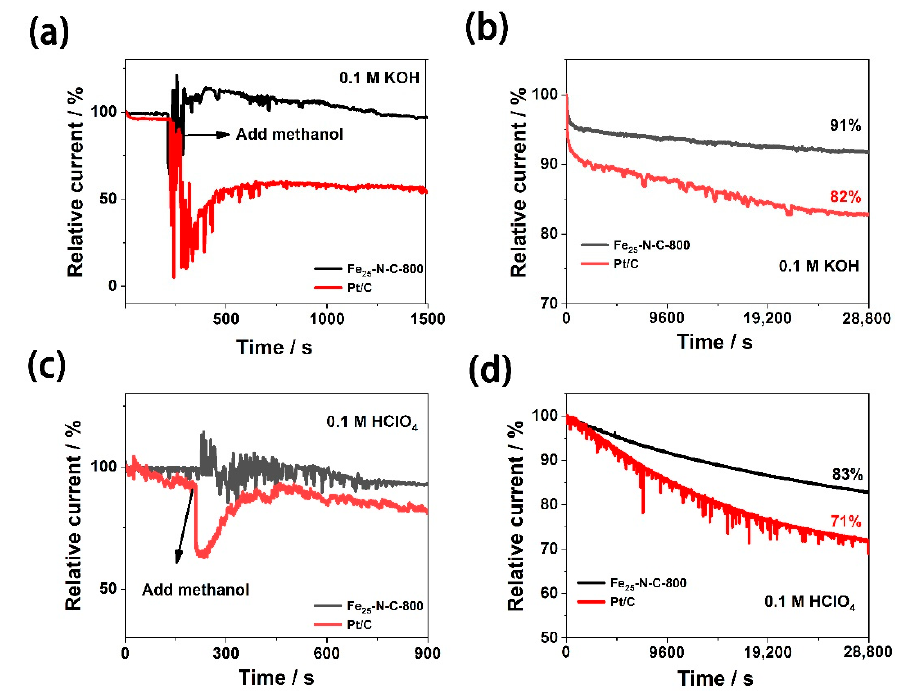
Figure 7. Chronoamperometric responses of Fe 25 -N-C-800 and commercial 20 wt.% Pt / C electrodes (100 rpm) upon the introduction of 3 M CH 3 OH ( a ) in 0.1 M KOH and ( c ) 0.1 M HClO 4 . Durability evaluation of Fe 25 -N-C-800 and Pt / C catalysts for 28,800 s ( b ) in 0.1 M KOH; ( d ) 0.1 M HClO 4 .